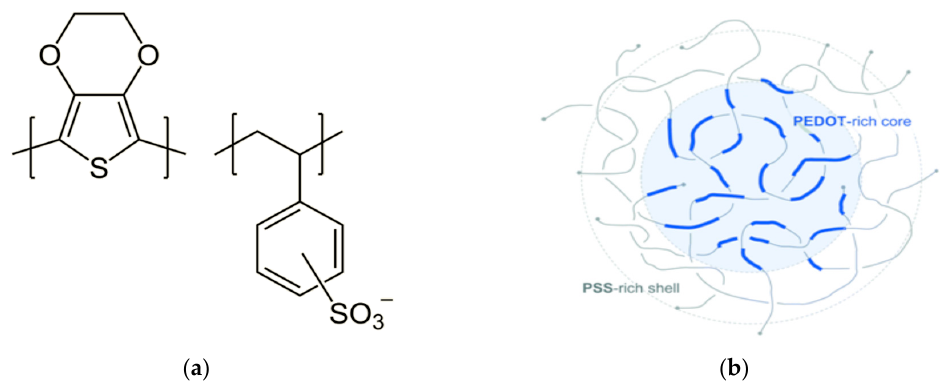
Figure 2. ( a ) Chemical structure of PEDOT:PSS; ( b ) core-shell structure of PEDOT:PSS, adapted from [52].